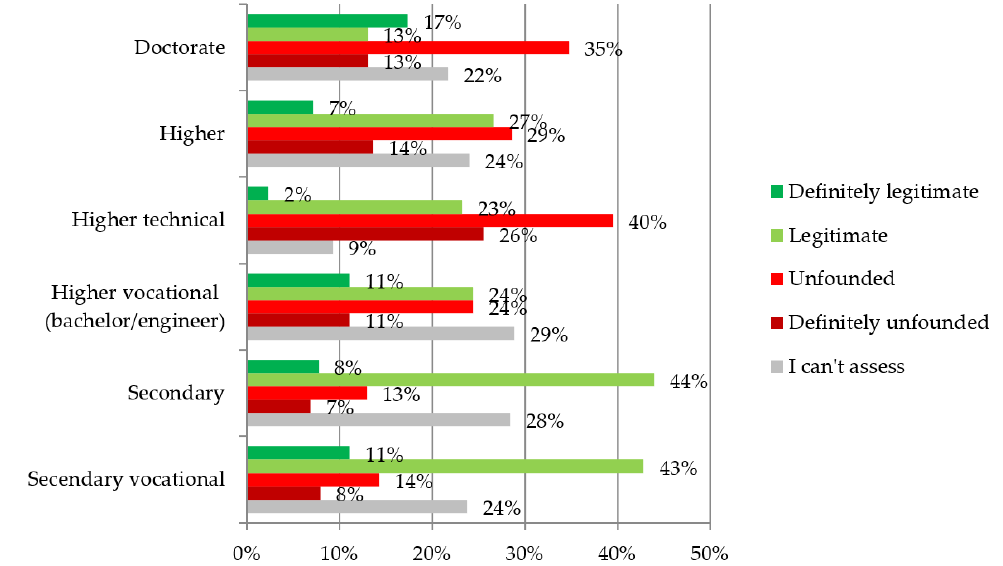
Figure 11. Education and assessment of the legitimacy of centralization of funds for decarbonization from the perspective of its effectiveness. Source: Own study based on the conducted research, n = 444.